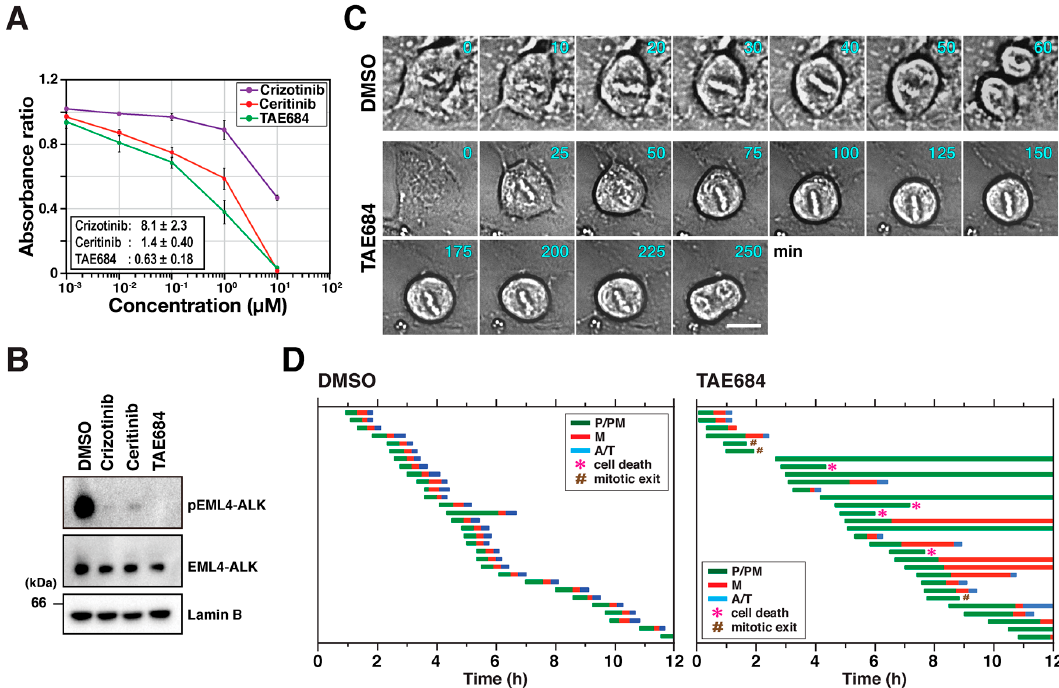
Figure 6. Inhibition of EML4-ALK fusion delays M phase progression. ( A ) H2228 cells were treated with inhibitors for 3 days, and viable cells were determined by WST-8 assay. Relative values of absorbance to solvent control (DMSO) are shown as mean ± SD calculated from three independent experiments. ( B ) H2228 cells were treated with DMSO, 8.2 µM crizotinib, 1.4 µM ceritinib, and 0.7 µM TAE684 for 1 h. Whole cell lysates were analyzed by WB with indicated antibodies. ( C , D ) Time-lapse imaging of asynchronous H2228 cells was performed for 12 h in the presence of DMSO and 0.7 µM TAE684. ( C ) Representative images of solvent control (DMSO) and TAE684-treated cells; scale bar = 10 µm. ( D ) Duration of P/PM (green), M (red), and A/T (blue) in individual cells (DMSO and TAE684, n = 30). * , cell death; #, mitotic exit.